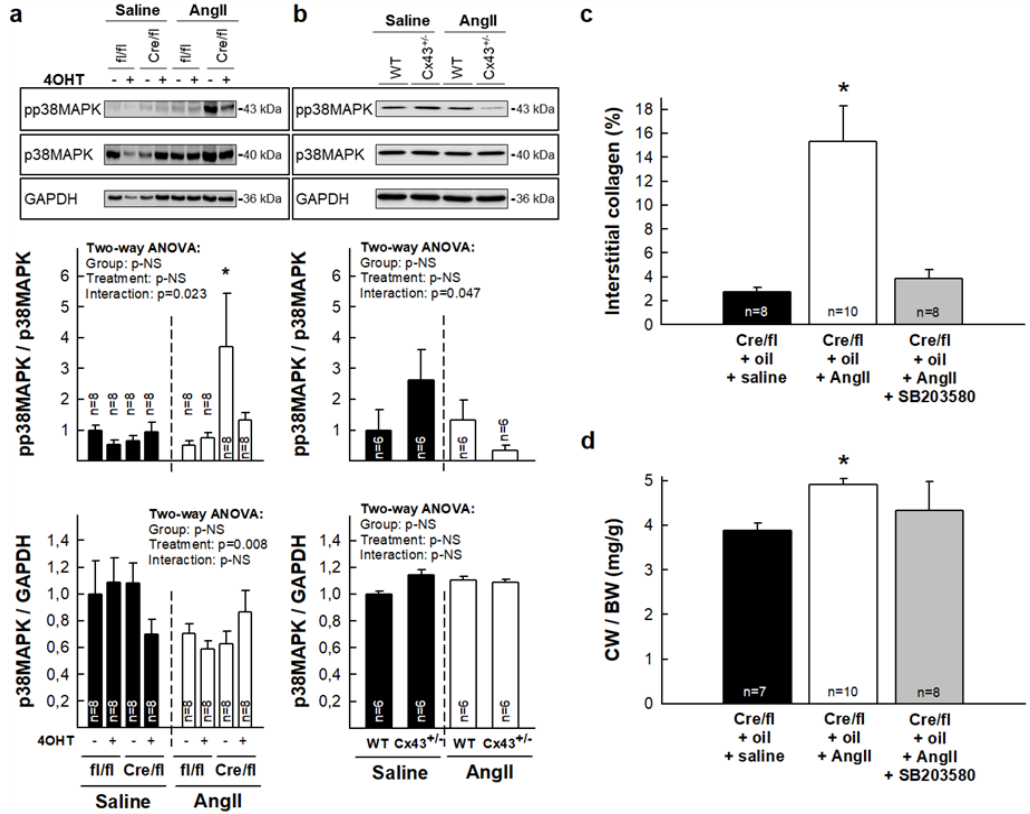
Figure 4. Enhanced collagen deposition in Cx43 Cre-ER(T)/fl + oil mice treated with AngII correlates with increased p38 MAPK activation. Expression and degree of activation of p38 MAPK in myocardial samples from Cx43 fl/fl (fl/fl) and Cx43 Cre-ER(T)/fl (Cre/fl) mice ( a ) and from wild-type (WT) and Cx43 +/- animals. ( b ) Upper panels show representative Western blots, whereas middle and bottom panels show degree of activation and total protein levels, respectively. * ( p < 0.05) indicates significant differences vs. the corresponding control Cx43 fl/fl group. ( c ) Interstitial collagen, expressed as percentage of total myocardial area, in hearts from Cx43 Cre-ER(T)/fl mice treated with oil and infused, for 14 days, with saline, AngII, or AngII plus the p38 MAPK inhibitor SB203580 (10 mg/Kg/day). ( d ) Changes in cardiac weight/body weight (CW/BW) ratio in the same animals. * ( p < 0.05) indicates significant differences vs. remaining groups.